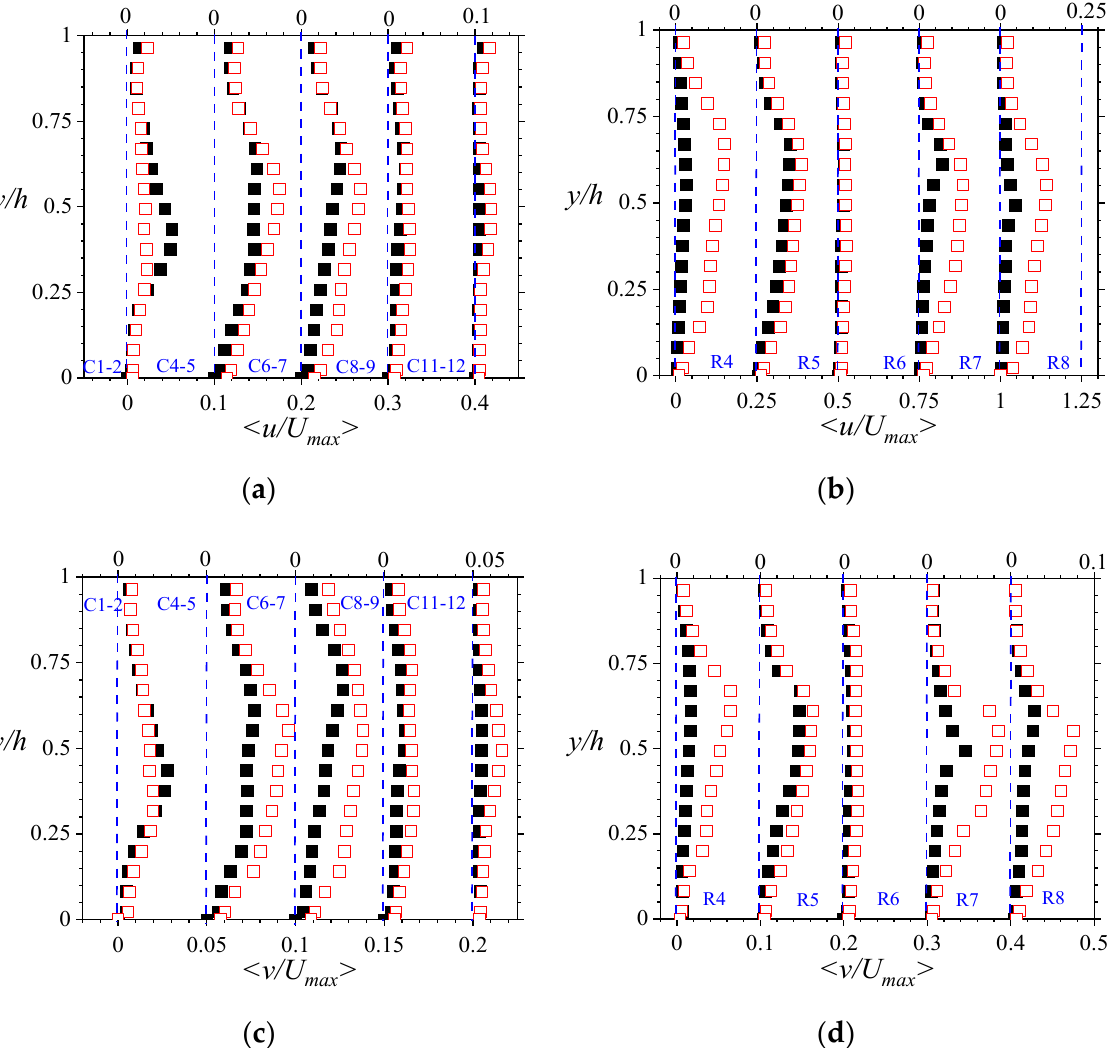
Figure 7. Parameters < u/U max > and < v/U max > are respectively line-averaged streamwise and wall-normal turbulence intensities normalized by the maximum local line-averaged streamwise mean velocity in both open and porous regions. Here, the profiles for the flow within the porous medium are shown. Staggered plots ( a , c ) show the streamwise variations whereas ( b , d ) demonstrate the spanwise variations. The denominations C and R respectively stand for columns and rows, and are illustrated in Figure 1. Black-filled boxes are for results for Test A , and red-open boxes are for results for Test B .